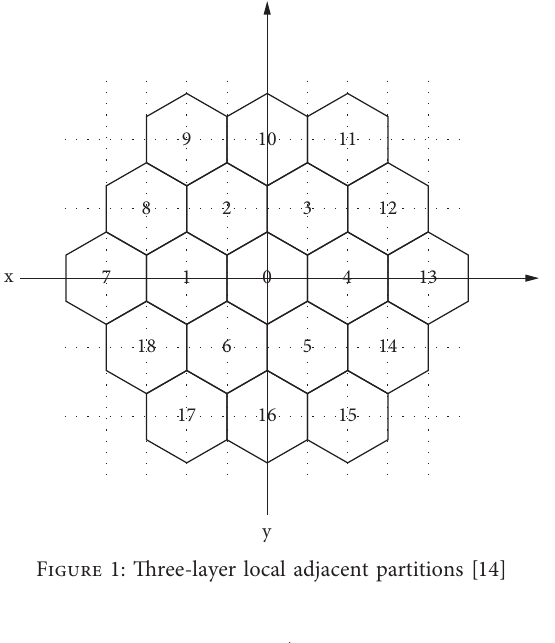
Figure 1: Three-layer local adjacent partitions